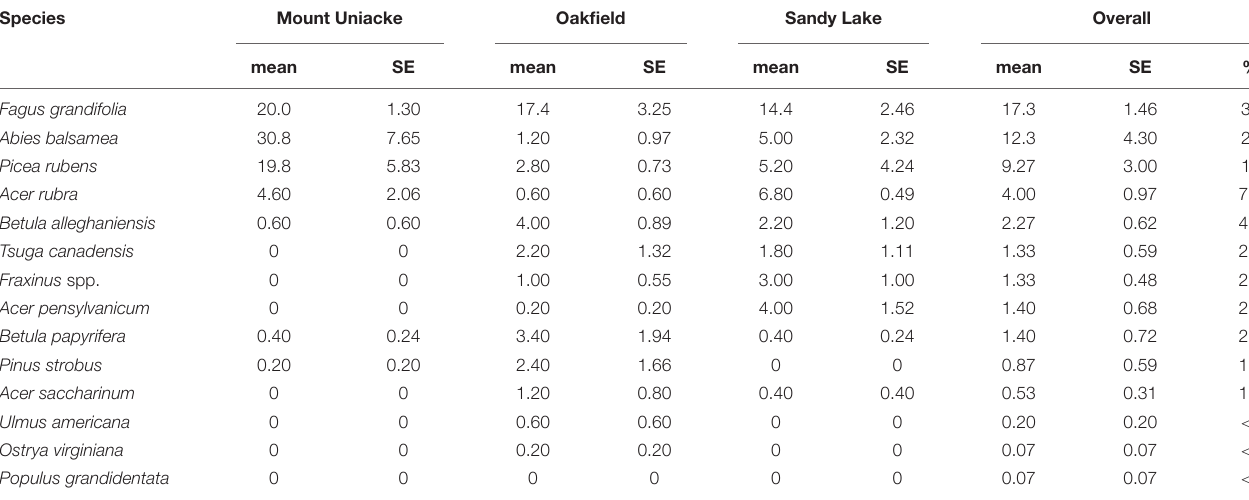
Betula papyrifera 0.40 0.24 Pinus strobus 0.20